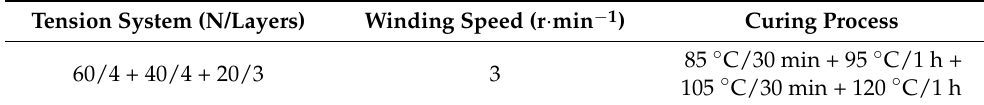
Figure 4. Winding mold of composite leaf spring. Table 3. Technological parameters of the filament winding